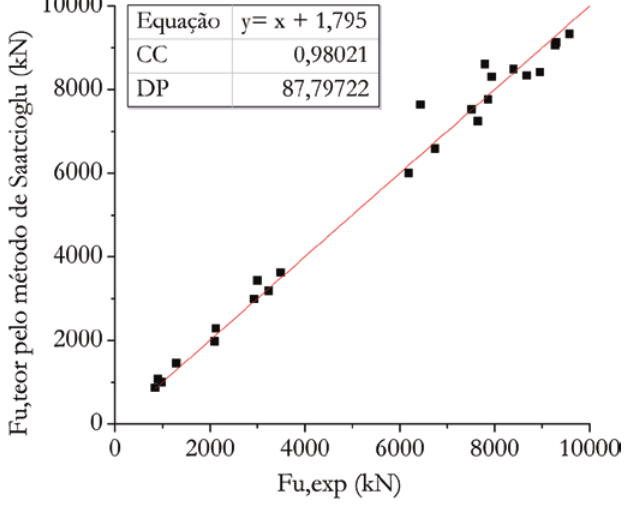
Comparação teórico-experimental da